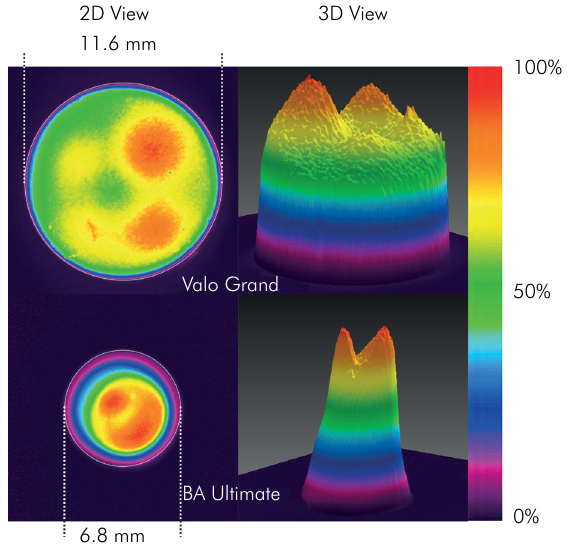
Figure 36. Light beam uniformity from two curing lights, one with a uniform light output (top figures) and one with a “hot spots” of very bright light and “cold spots” (bottom figures).